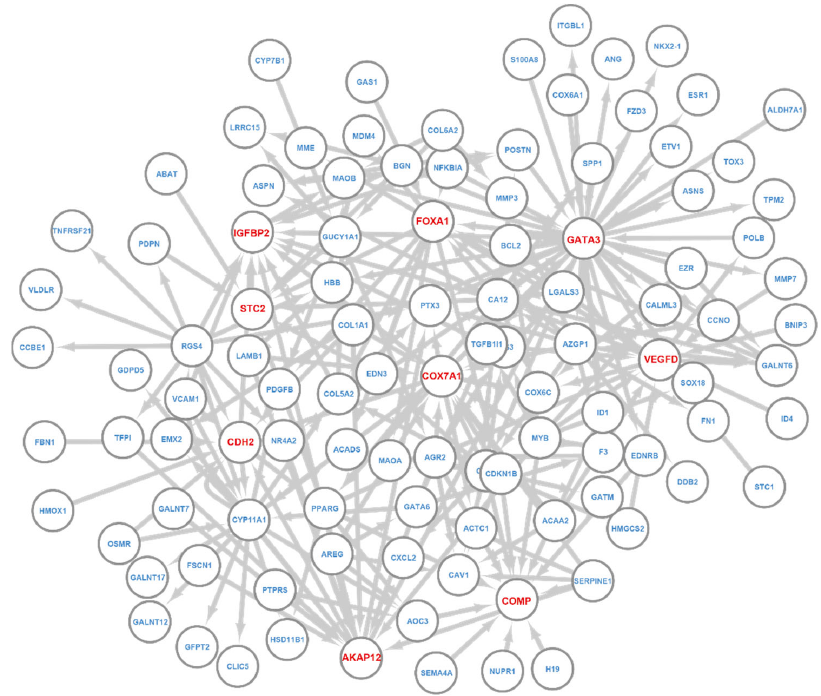
Figure 4. T ‐ GEM regulatory network of the last layer for BRCA. Nodes are informative genes and their associated Key genes. Links go from Key to Query genes. Genes with red color are hub genes.